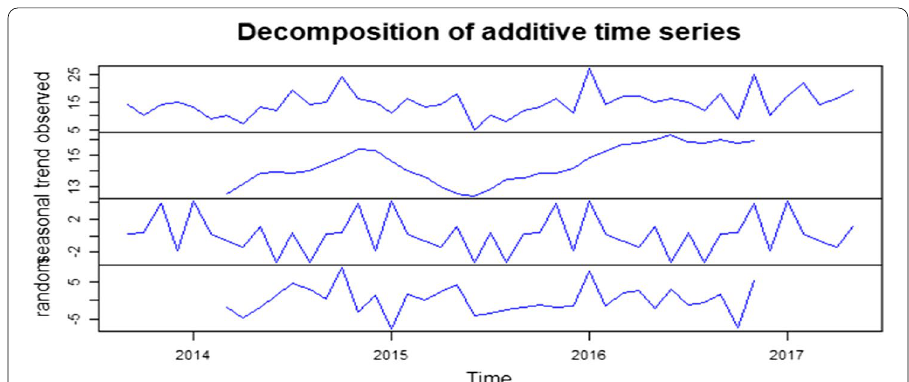
Fig. 3 Time series decomposition of fatal RTA data